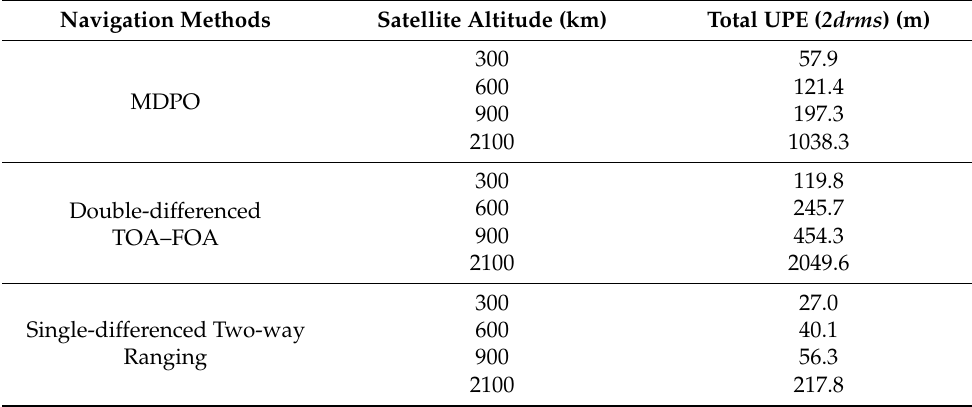
Table 4. One example of correlation between the satellite altitude and Total UPE: two satellites were placed in different circular LLO, 300, 600, 900, and 2100 km. The simulation takes an average of 100 simulation cases for